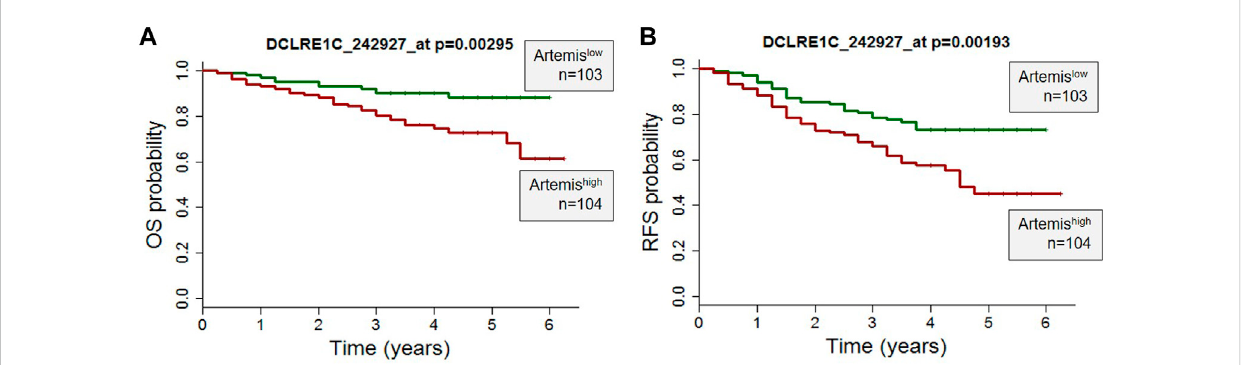
FIGURE 1 High Artemis expression is associated with poor outcome in primary B-ALL. (A) A probe set for Artemis in 207 pediatric ALL cases from COG study P9906 were analyzed. RNA was puri fi ed from 207 pretreatment diagnostic samples with more than 80% blasts (131 BM, 76 PB). (A) Overall Survival Probability (OS) and (B) Relapse Free Survival (RFS) of Artemis low ( n = 103) and Artemis high ( n = 104) are shown. p -values were obtained from the Wilcoxon test for each probe set (* p = 0.00295 and * p =0.00193 for probe 242927_at).